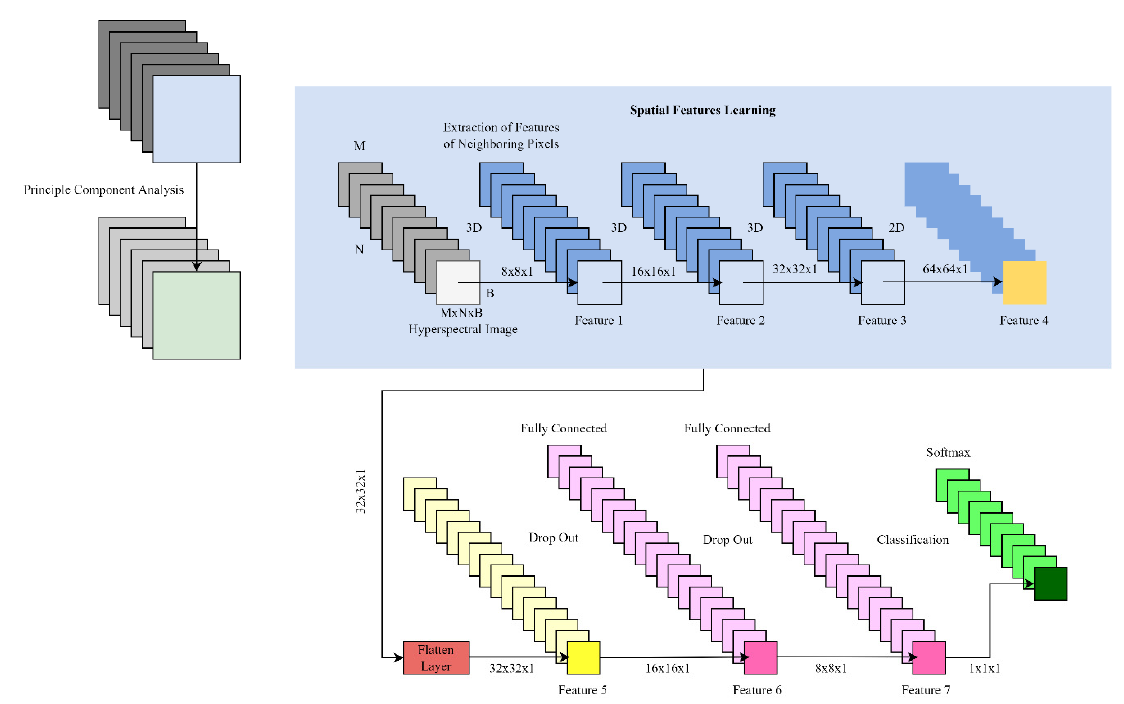
Figure 5. Proposed 3D ‐ CNN Architecture.